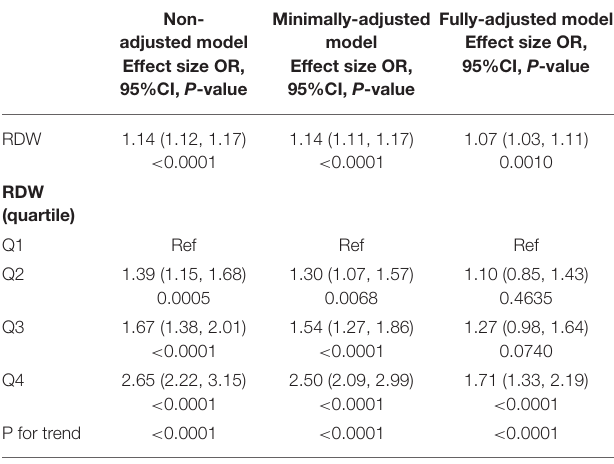
TABLE 2 | Results of binary logistic regression